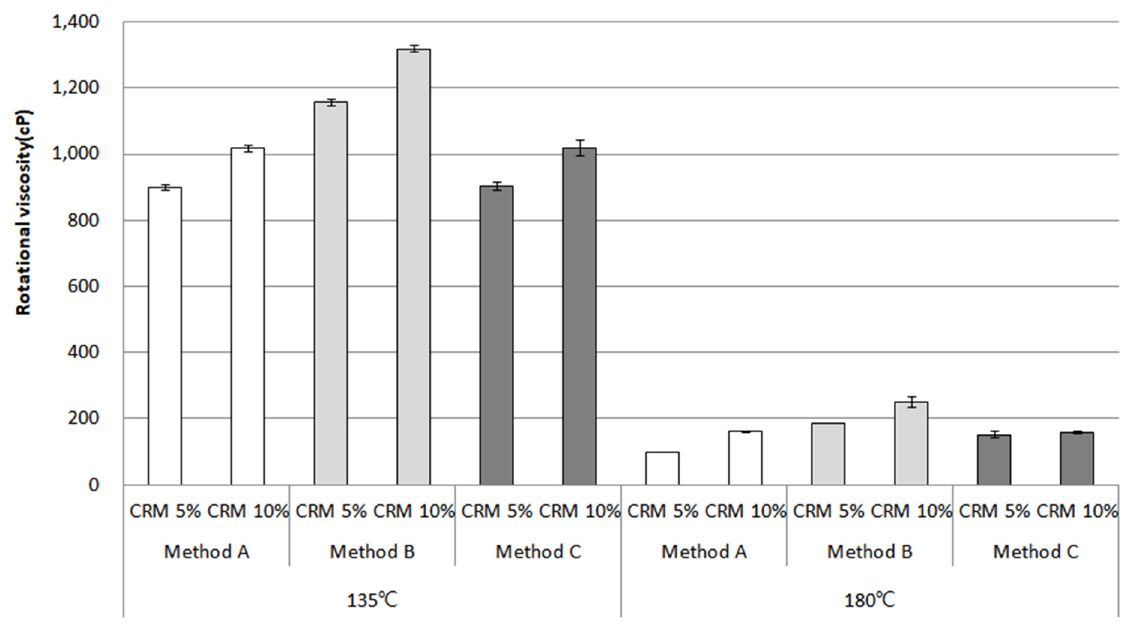
Figure 7. Rotational viscosity of the CRM asphalt binders in each mixing method for the original condition.